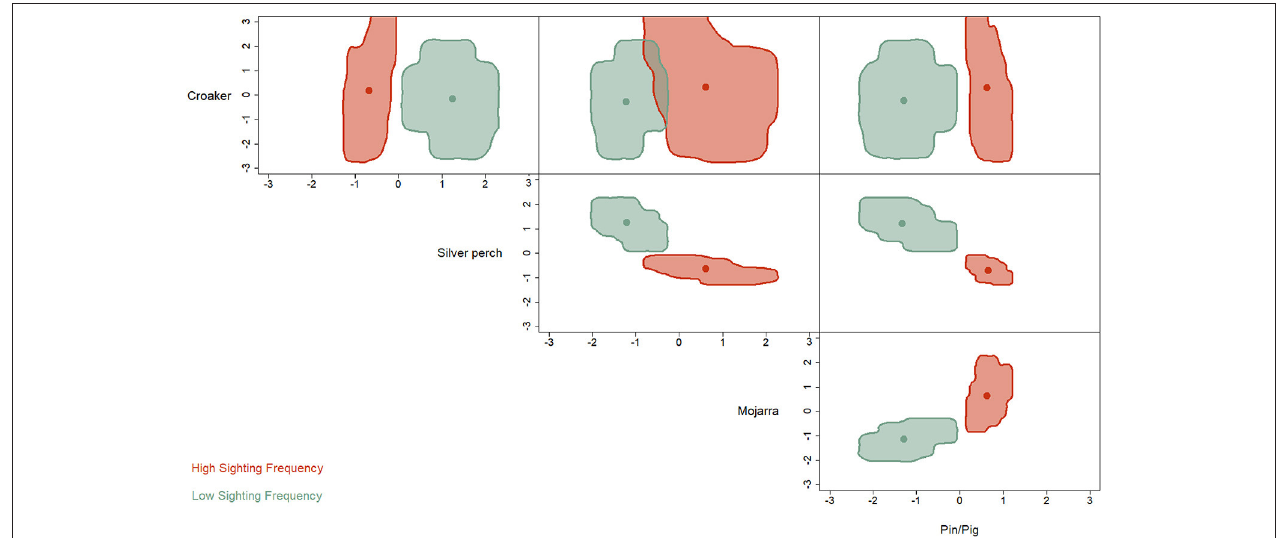
FIGURE 3 | Niche hypervolume metrics indicate that HSF individuals (blue) feed more heavily on seagrass associated prey items (mojarra and pinfish/pigfish) than LSF dolphins who prefer silverperch.